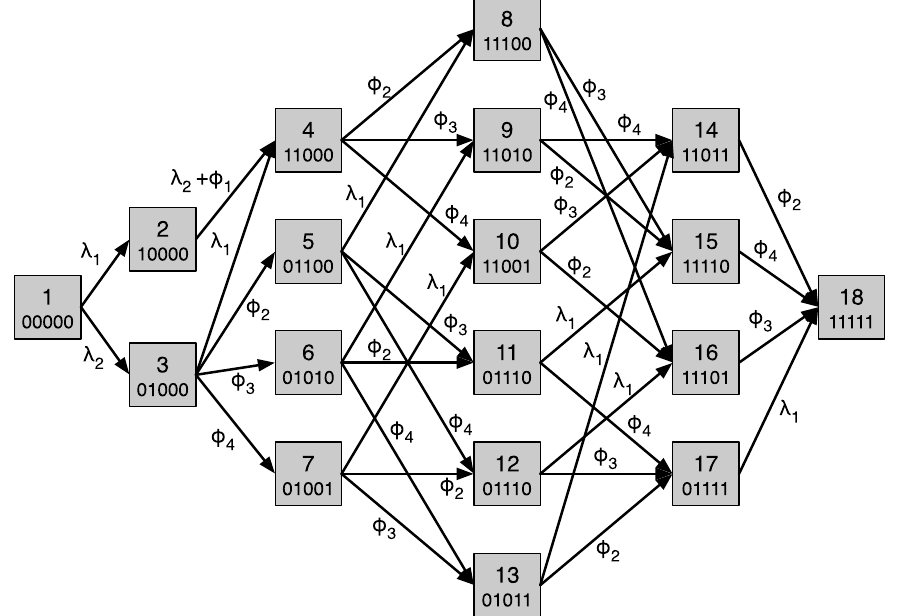
Fig 7. The state transition diagram for the ovarian cancer model. Each node corresponds to a possible metastatic state and is represented by a binary string which signifies which organ is positive or negative for metastases. For convenience the nodes are named from 1 to 18. The rates are obtained from the flow rates in the anatomic network (Fig 3) by considering the rate at which individual sites become positive based on the state of the other